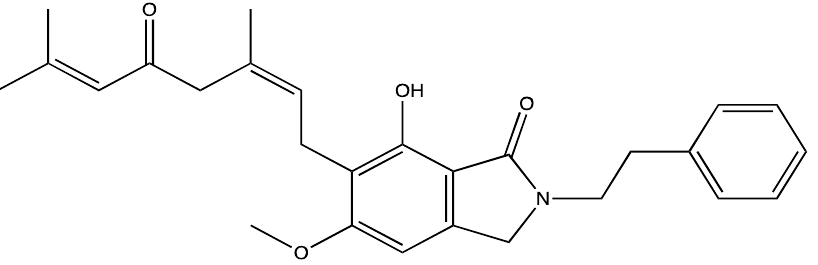
Figure 17. Structure of hericenone B isolated from ethanolic extract of Hericium erinaceus.